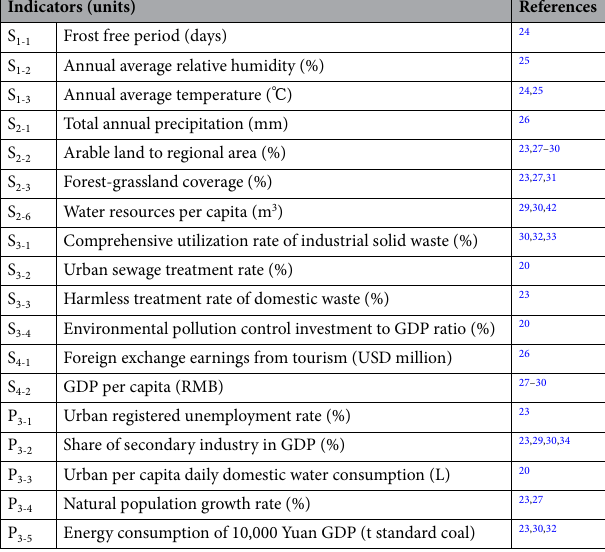
Table 1. Summary of typical ecological base evaluation indicators in previous